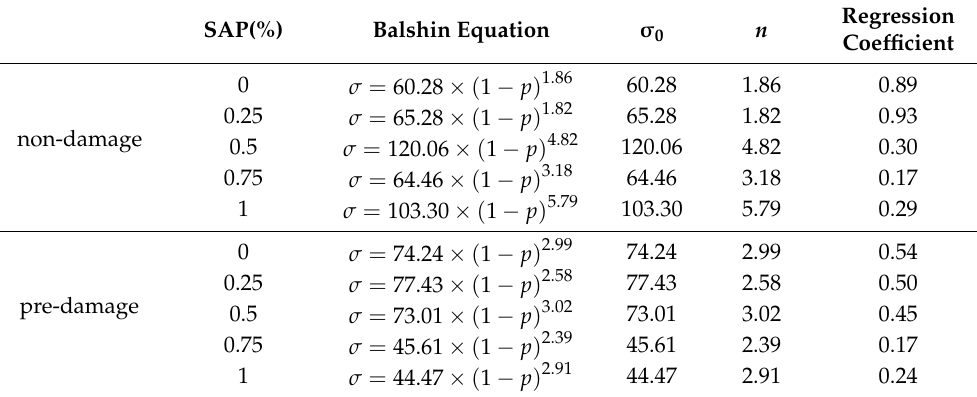
Table 5. The Balshin equation and regression coefficient.